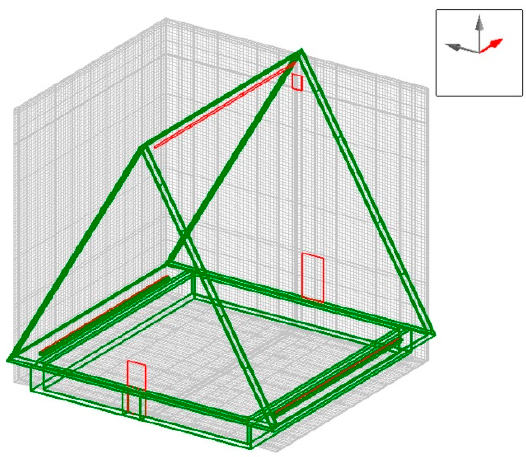
Figure 5. Three-dimensional CFD model and mesh structure with 0.8 million cells (openings are in red).